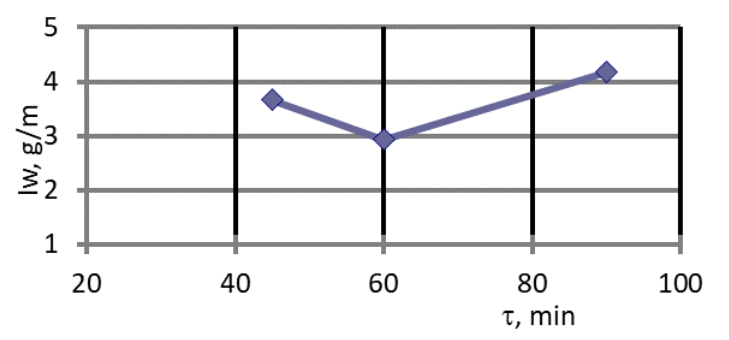
Fig. 2. Dependence of wear intensity of B-95 alloy on molding time